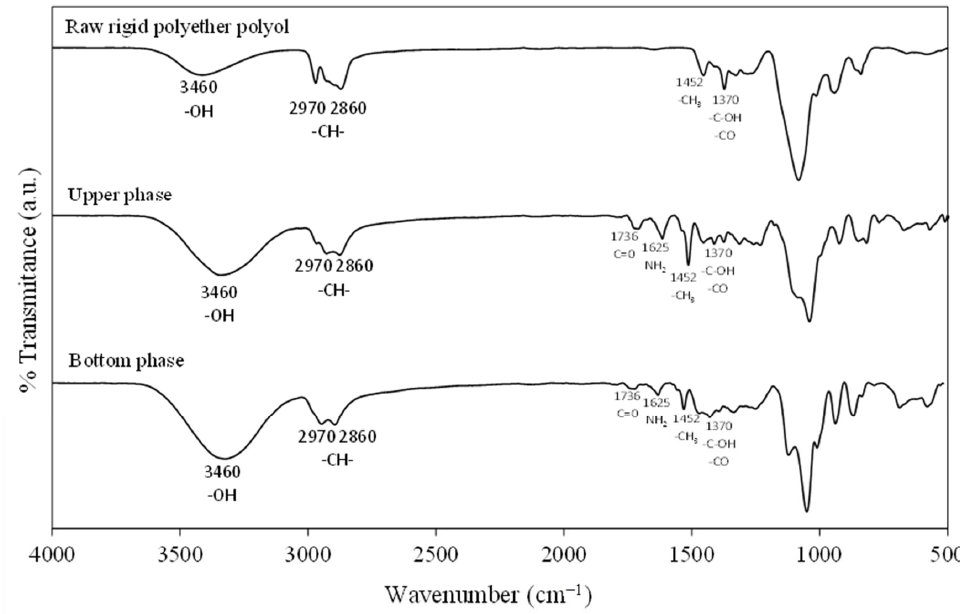
Figure 5. FTIR spectra of the raw polyol and the upper and bottom phases from the glycolysis reaction. The FTIR spectra of raw polyol and UP present the typical functional groups of a polyol, showing the signals corresponding to the hydroxyl groups OH at 3460 cm −1 , CO